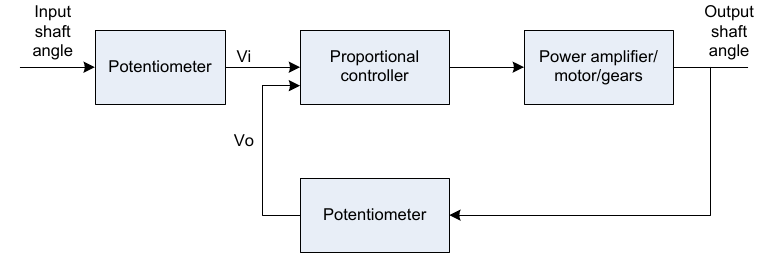
Fig. 1. Block diagram of the position control